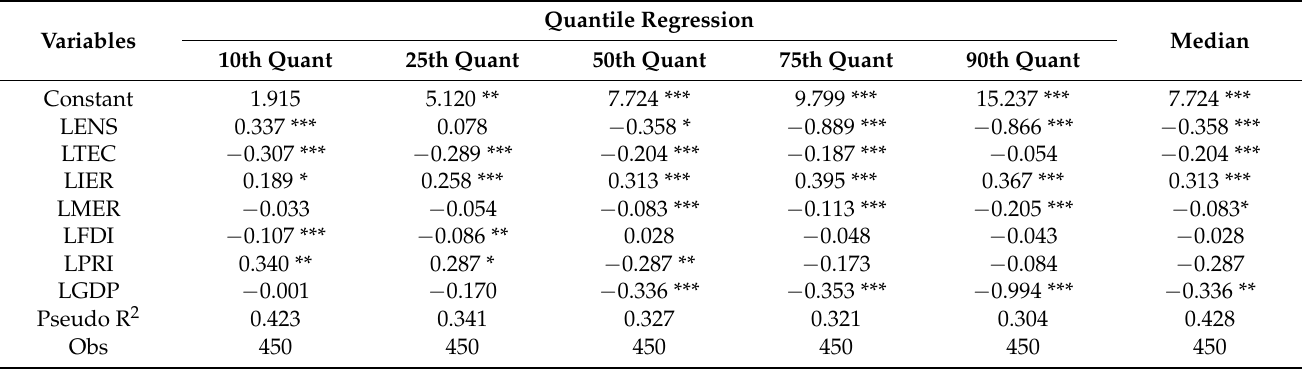
Table 8. Robustness test: the results of quantile